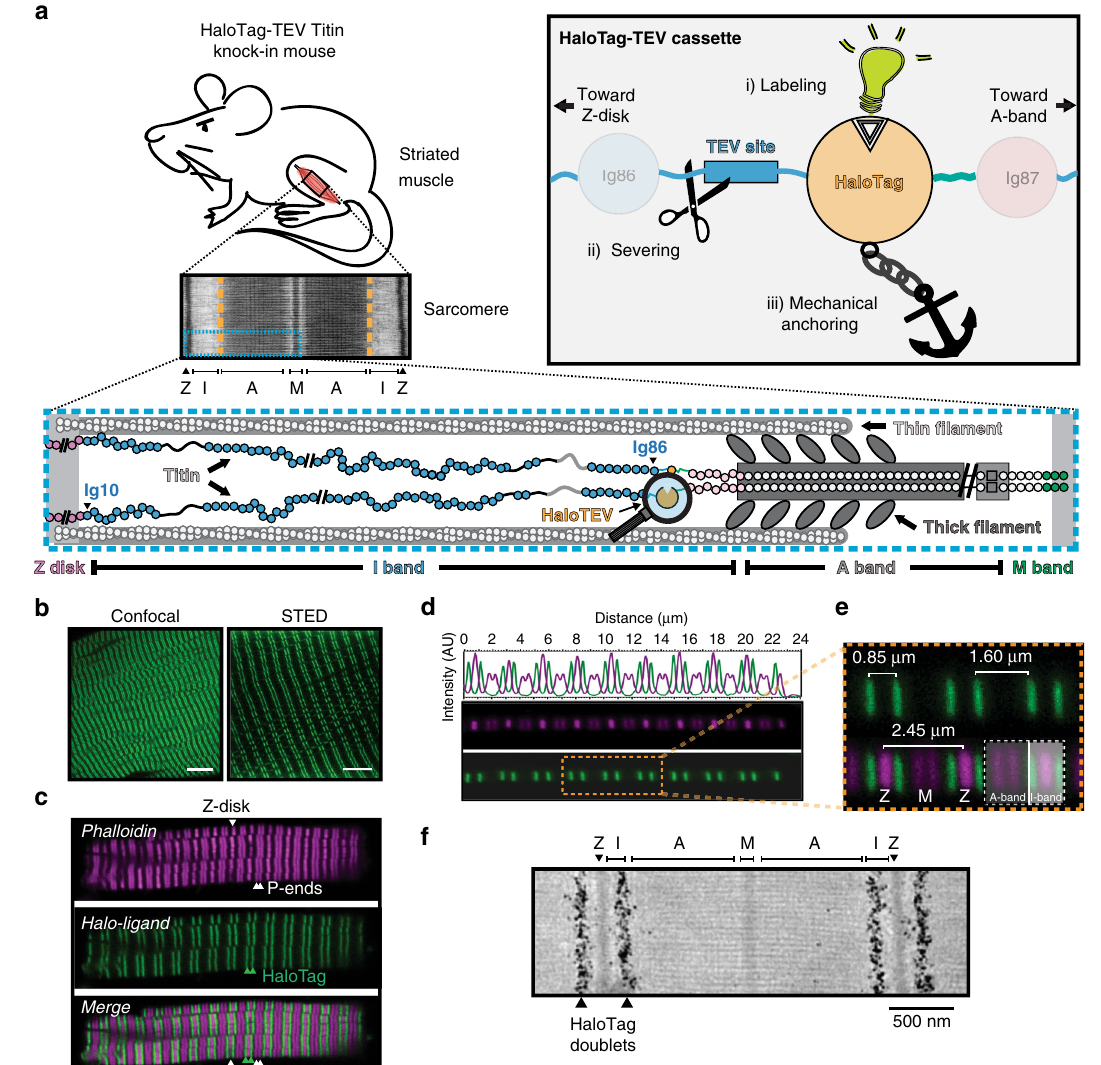
Fig. 1 The HaloTag-TEV cassette. a We inserted the HaloTag-TEV cassette in the TTN gene to generate a mouse model for the study of the mechanical properties of titin. Bottom: Schematic representation of one half-sarcomere showing the three main fi laments of sarcomeres: the thin fi lament, the thick fi lament and titin. A single-titin molecule spans from the Z-disk to the M-band. The HaloTag-TEV knock-in cassette is located at the end of the I-band, between the I86 and I87 domains. Inset: The HaloTag-TEV cassette allows (i) speci fi c labeling, (ii) titin severing to examine tissue mechanics, and (iii) covalent anchoring for single-molecule force spectroscopy. b Gastrocnemius muscle extracted from homozygous knock-in HaloTag-TEV titin mice is labeled with the membrane permeable Oregon Green HaloTag ligand, fi xated and cleared following the X-Clarity method. The specimen is then imaged using confocal and STED microscopies. The scale bars correspond 10 and 5 μ m, respectively ( n = 1 experiment; more than fi ve fi elds of view showed equivalent results). c Freshly extracted psoas myo fi brils are stained with Alexa488 HaloTag ligand and Alexa Fluor 647 phalloidin, and subsequently imaged using confocal microscopy (experiment was repeted three times with two different muscles leading to equivalent results). Phalloidin speci fi cally binds naked actin, resulting in strong fl uorescent signal at the Z-disk region and the pointed ends of the thin fi lament (P-ends), as indicated by white arrowheads. According to the pattern of phalloidin labeling, the HaloTag appears correctly positioned fl anking the A-band of every sarcomere (green arrowheads). Thus, the HaloTag doublet pattern corresponds to the HaloTag-TEV cassette fl anking two I-bands from two juxtaposed sarcomeres. Scale bar, 7.5 μ m. d , e A single psoas myo fi bril labeled with Alexa488 HaloTag ligand and Alexa Fluor 647 phalloidin is used to measure the distance between fl uorescent bands. The HaloTag doublets are separated approximately 1.5 – 1.6 μ m, while the distance between the bands in the doublets is variable (0.85 μ m in this particular example) as a consequence of different contraction states of sarcomeres (representative image from four preparations). f Representative EM image out of n = 200 micrographs showing the location of gold-particle-labeled HaloTag in soleus